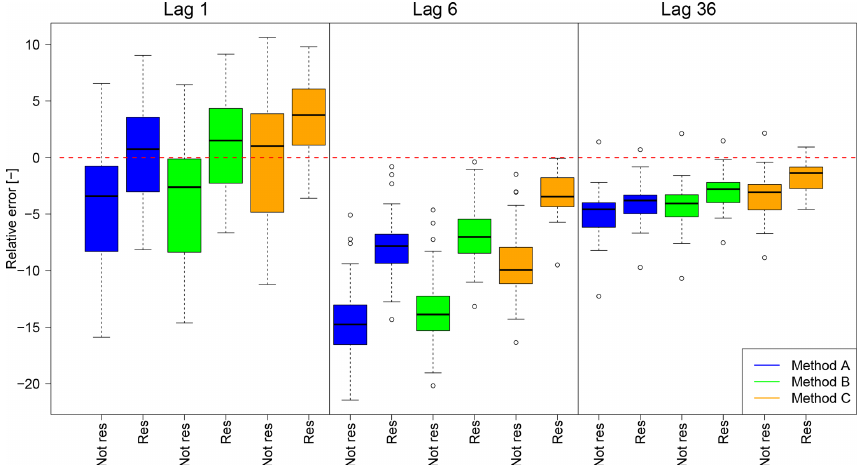
Figure 11. Deviations of autocorrelation from disaggregated to observed time series before and after the resampling as relative error for lags 1, 6 and 36. All results are based on the MMD approach. The red dashed line indicates a rE = 0, results for the resampled time series are labelled with